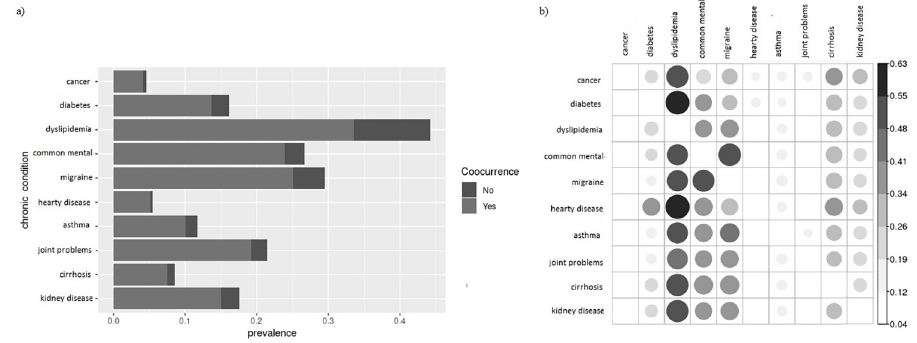
Fig 1. Prevalence and cooccurrence of chronic conditions. a) Prevalence of chronic conditions (light gray + dark gray), occurring jointly with other conditions (light gray) and occurring without any condition (dark gray); b) Prevalence of y-axis comorbidities among participants who have x-axis conditions; common mental–common mental disorder.